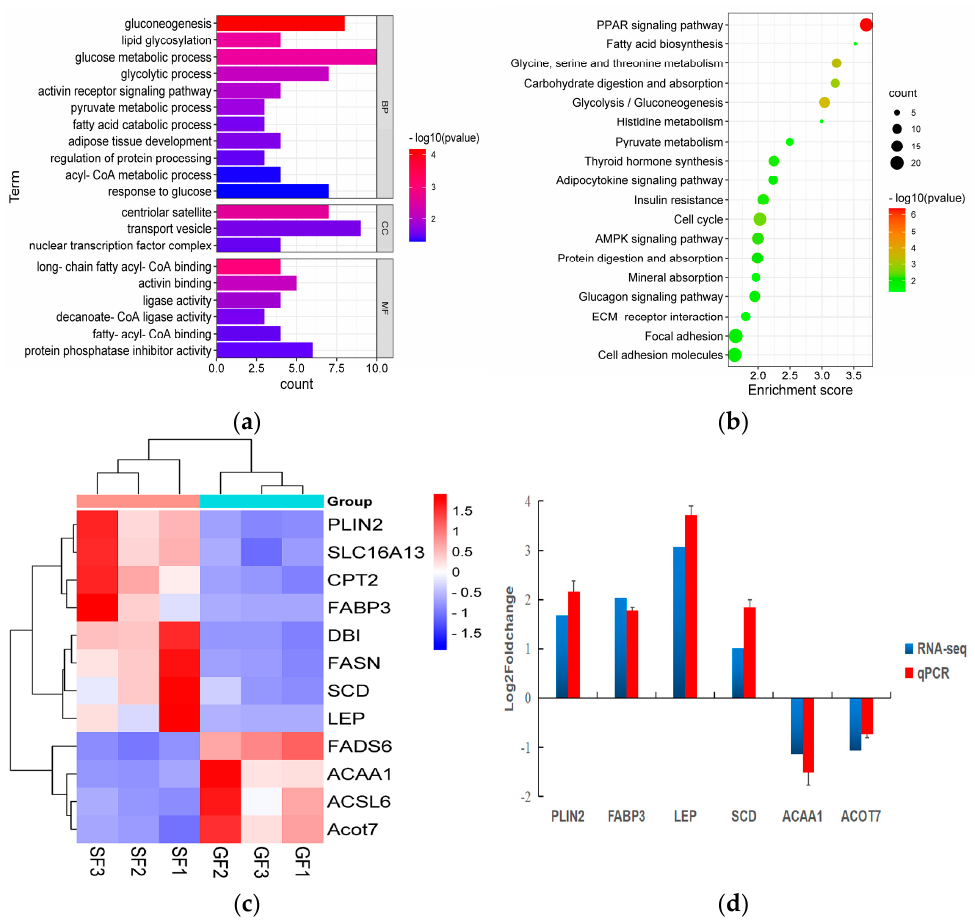
Figure 4. ( a ) The histogram of the Gene Ontology (GO) enrichment analysis of differentially expressed genes (DEGs) in yak LD under GF and SF. The items of GO enrichment analysis are divided into biological processes (BPs), cellular components (CCs) and molecular functions (MFs). ( b ) The bubble chart of the KEGG pathway enrichment analysis of DEGs in yak’s LD under GF and SF. The abscissa represents the enrichment score which is the ratio of the number of DEGs in a certain KEGG item with the total number of backgrounds identified in the KEGG pathway. The color represents the value of -log10 P , and the size of circle represents the number of DEGs in the KEGG item. ( c ) The heatmap of the crucial DEGs ( PLIN2 , SLC16A13 , CPT2 , FABP3 , DBI , FASN , SCD , LEP , FADS6 , ACAA1 , ACSL6 and ACOT7 ) involving in the regulation of fatty acids content in yak’s LD under SF and GF. ( d ) The comparison for the values of log 2 fold change (FC) in six DEGs ( PLIN2 , FABP3 , LEP , SCD , ACAA1 and ACOT7 ) between the results of qPCR and